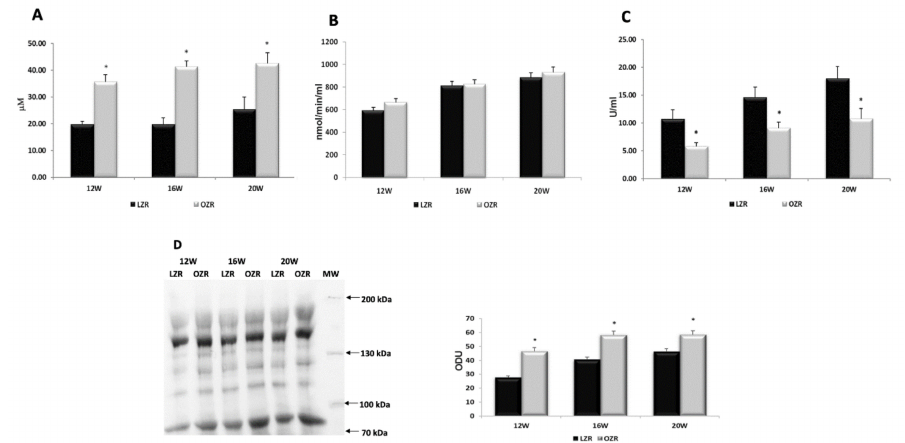
Figure 1. Oxidative stress in plasma. ( A ) Concentration of thiobarbituric acid reactive substances (expressed in µ M); ( B ) glutathione peroxidase (expressed as unit defined as the amount of enzyme that will cause the oxidation of 1.0 nmol of NADPH to NADP + per minute at 25 ◦ C); ( C ) superoxide dismutase (expressed as U / mL where one unit is the amount of enzyme needed to exhibit 50% dismutation of the superoxide radical) activities in plasma of lean Zucker rats (LZR black bar) and obese Zucker rats (OZR gray bar) at the age of 12, 16, and 20 weeks (X axis); ( D ) samples of plasma from LZR and OZR rats at di ff erent ages were immunoblotted using OxyBlot kit. Bar graph reports the values of optical density measured in optical density unit (ODU). Data are mean ± S.E.M. * p < 0.05 vs. age-matched